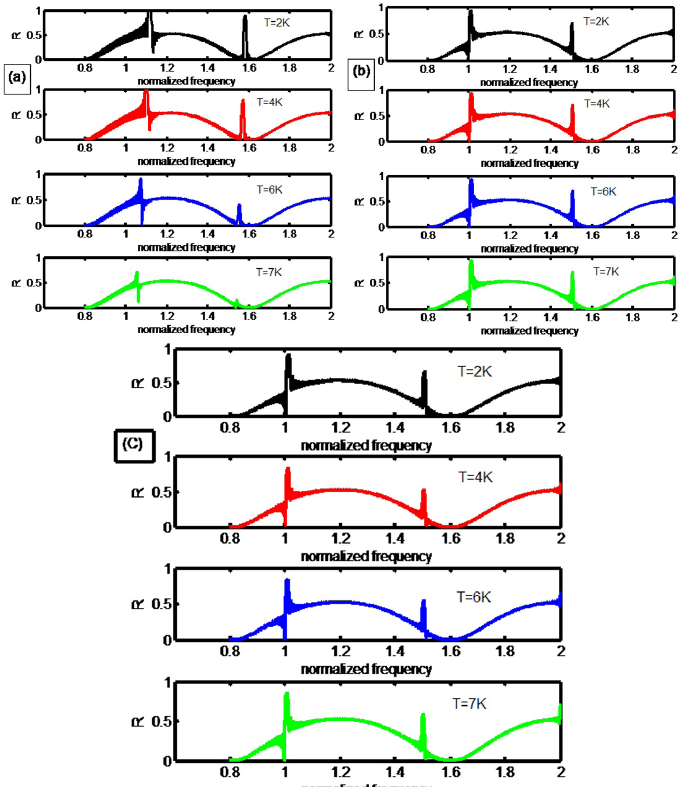
Figure 4. Reflectance spectra versus normalized frequency of the three periodic superconducting PC and for different values of the